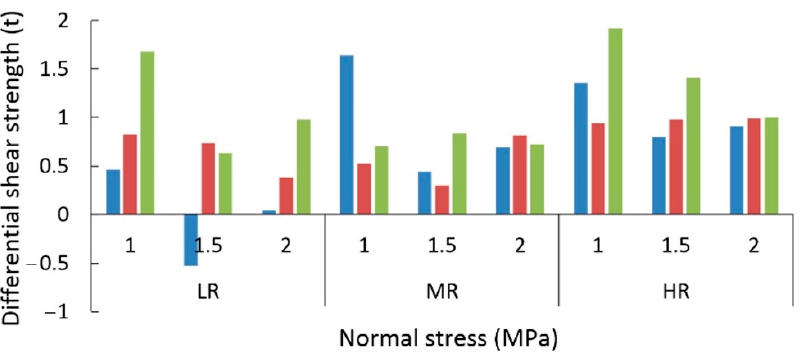
Figure 12. The difference between peak shear loads obtained from case I and case II experiments.